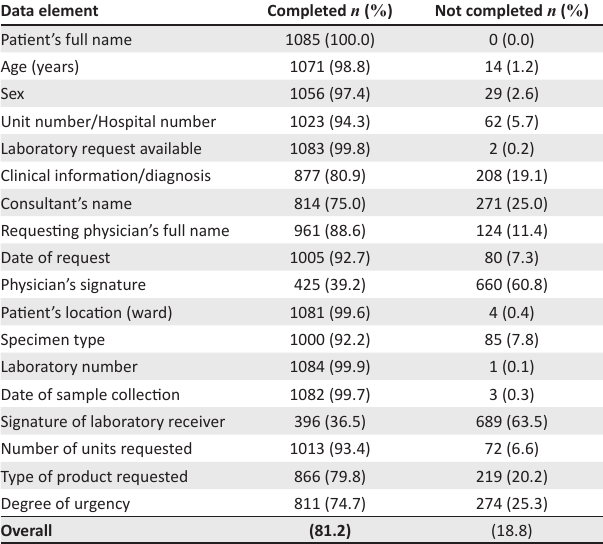
TABLE 1: Completeness of laboratory request forms submitted to Department of Haematology of Aminu Kano Teaching Hospital, Kano, Nigeria, from October 2014 to December 2014 ( n = 999). Data element